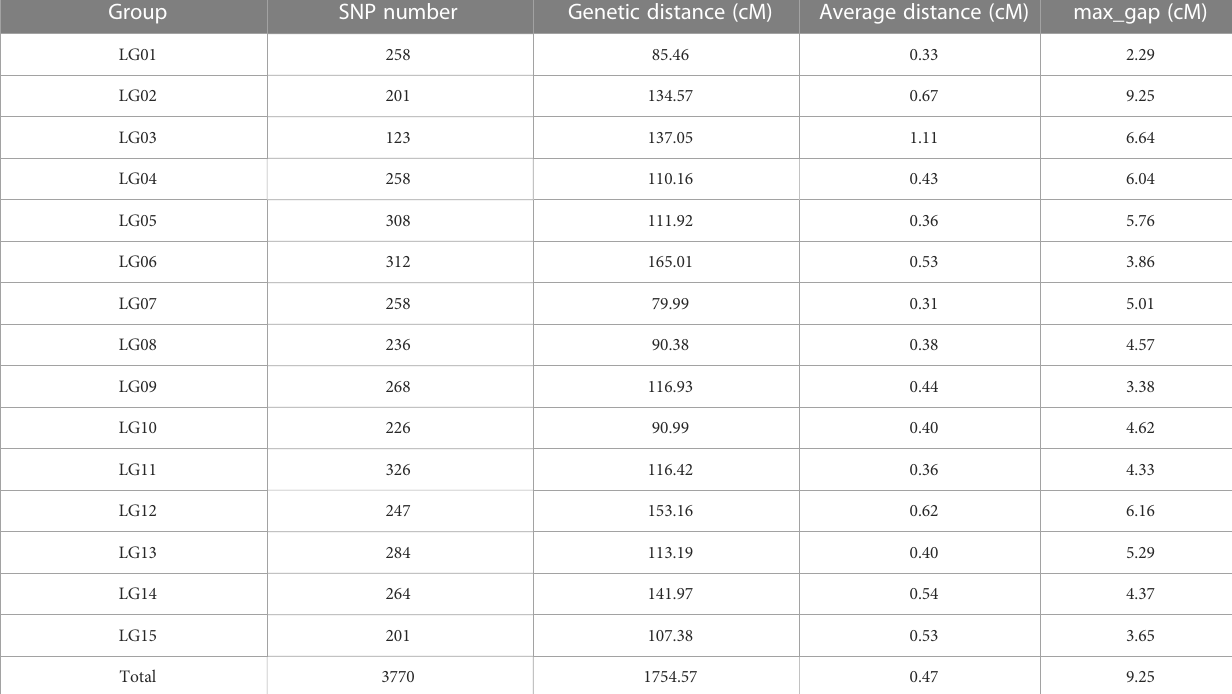
TABLE 1 Information and statistics of the genetic map.